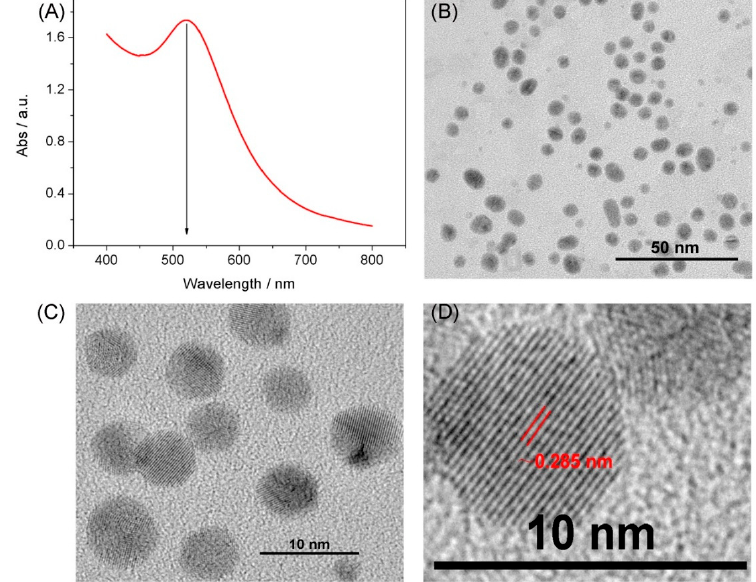
Figure 1. UV-vis adsorption spectrum of CP5@Au-NPs ( A ); TEM image of CP5@Au-NPs ( B ); HRTEM images of CP5@Au-NPs ( C , D ). images of CP5@Au-NPs ( C , D